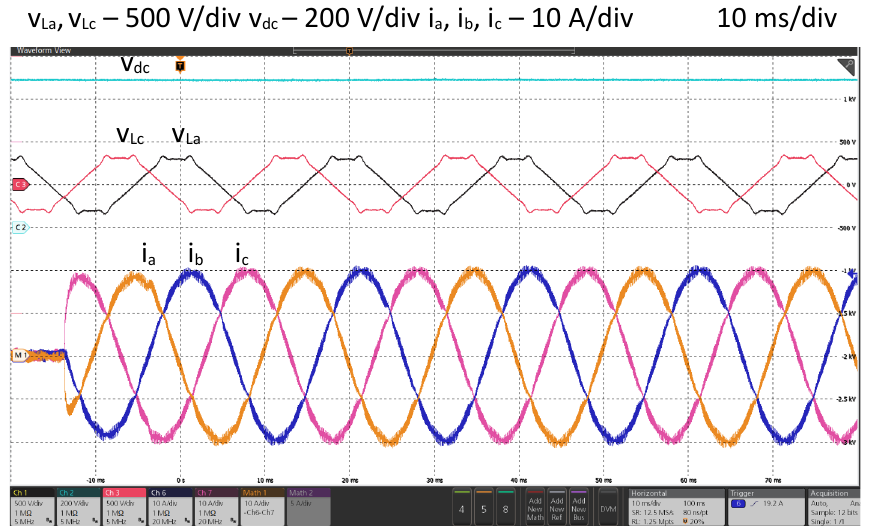
Figure 21. Experimental result for the step change i ∗ q for control insensitive to reference signal